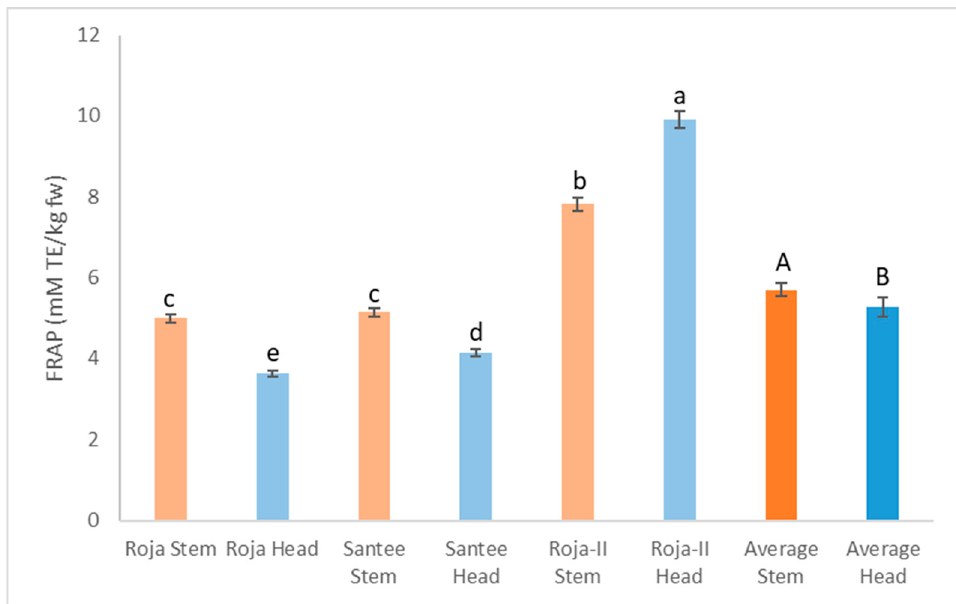
Figure 1. Average values and standard deviation of total antioxidant capacity measured by Ferric Reducing Antioxidant Power (FRAP) of Broccoli analyzed: Roja, Santee and Roja-II harvest divided into head and stem, and their average. Values with the same lowercase letter were not significantly different (Test SNK p ≤ 0.05, n = 3). Lowercase letters refer to Roja, Santee and Roja-II harvest divided into head and stem. Values with the same uppercase letter were not significantly different (Test SNK p ≤ 0.05, n = 9). Uppercase letters refer to head and stem average values.